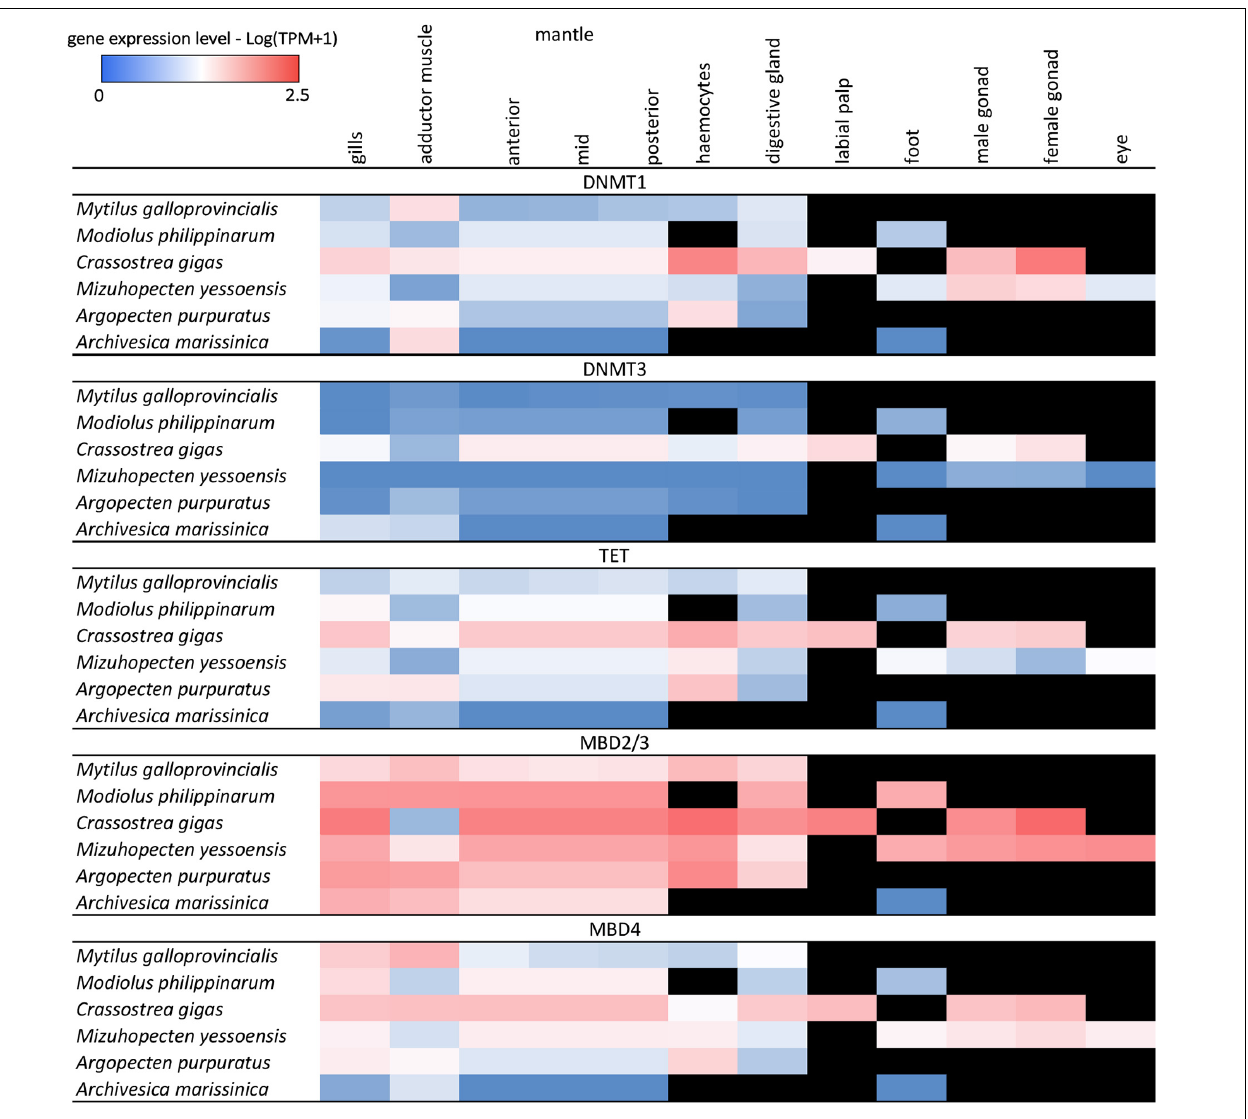
FIGURE 6 | Heat map of DNA methylation-related genes expression in adult tissues of 6 bivalve species from transcriptome database. Black cells indicate missing